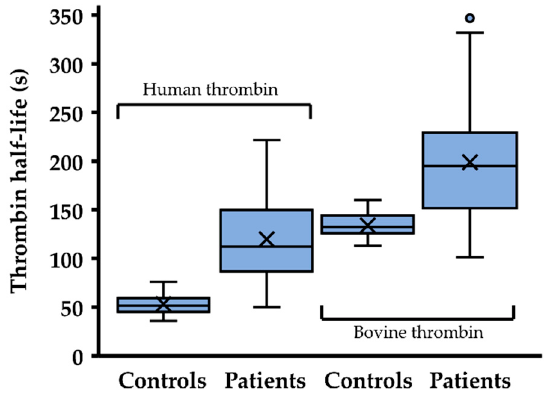
Figure 2. Inactivation rates of thrombin in healthy individuals and antithrombin (AT)-deficient patients. The half-life of exogenously added thrombin (2 ng/mL final concentration) was determined in healthy controls ( n = 26) and patients with AT mutations ( n = 36, human thrombin; n = 19, bovine thrombin). The boxes show quartiles and the median of the data, the whiskers extend up to 1.5 times of the interquartile range from the box, and circles show outlying data values. X indicates the mean.